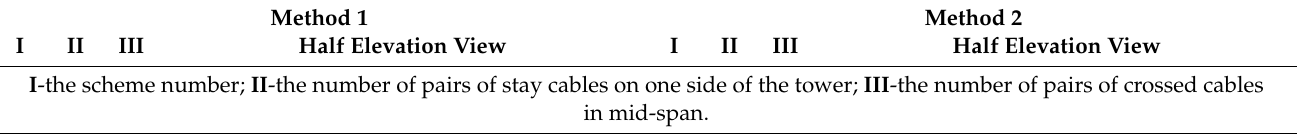
Table 1. Parameters of contrast scheme with crossed cables.